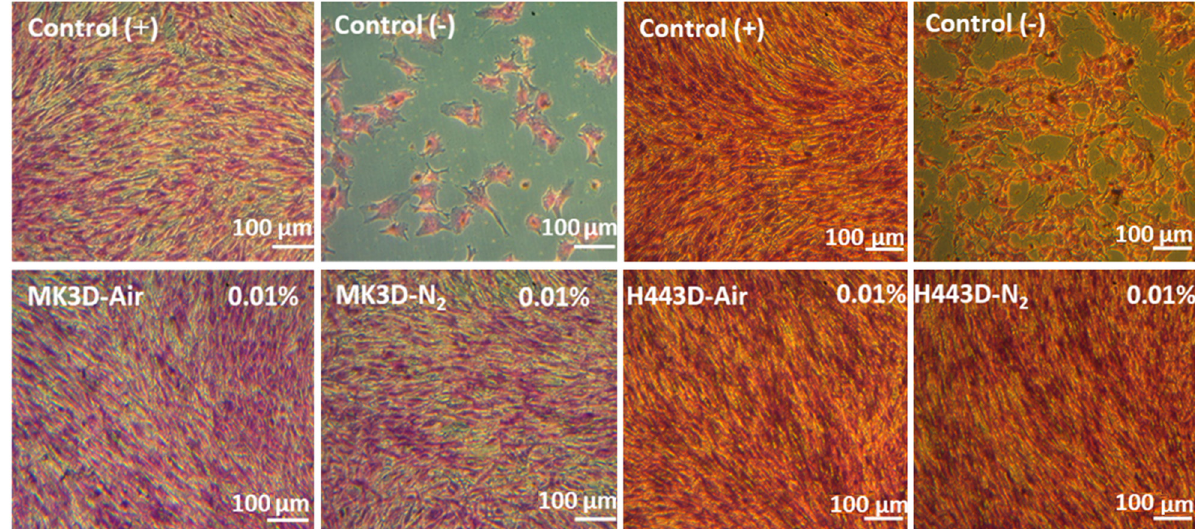
Figure 8. Light microscopy images of H&E-stained ST2 cells cultured with the 0.01% w/v extracts of MK and H44–based Biosilicate ® -like 3D scaffolds.